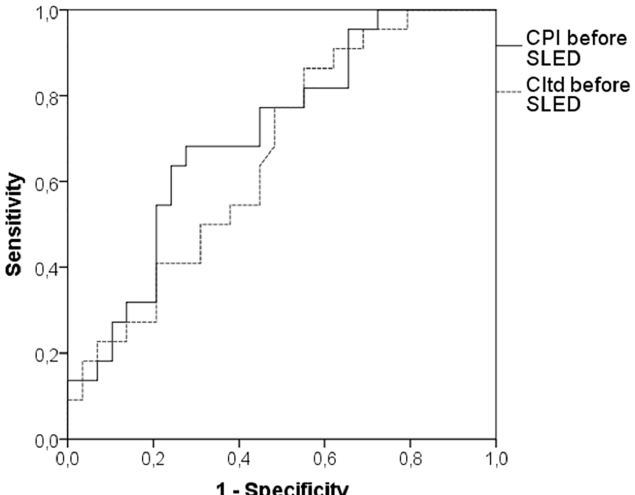
Fig 6. ROC-analysis regarding the primary